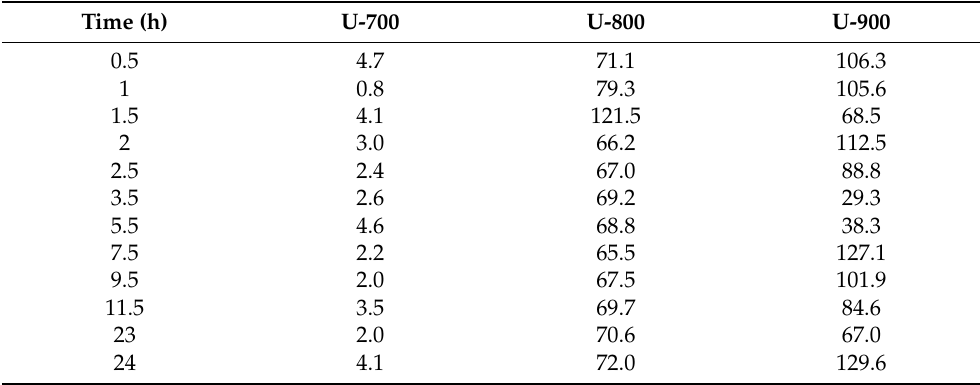
Table 3. The WA content (mg/g) with time of the vermiculite heated at temperatures between 700 °C and 900 °C.